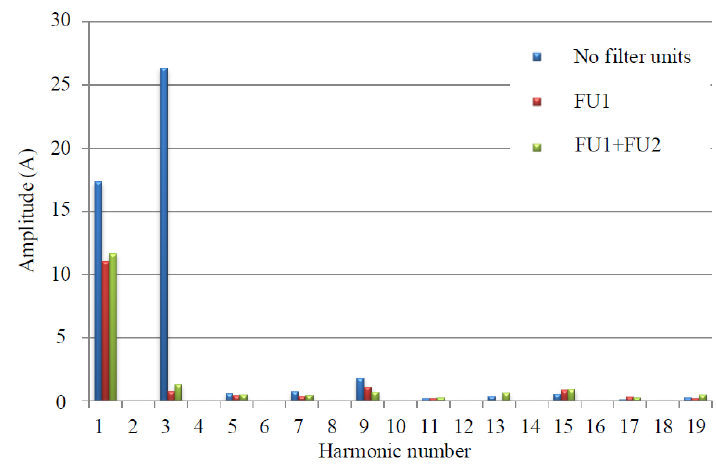
Figure 21. The current i SN spectrum.